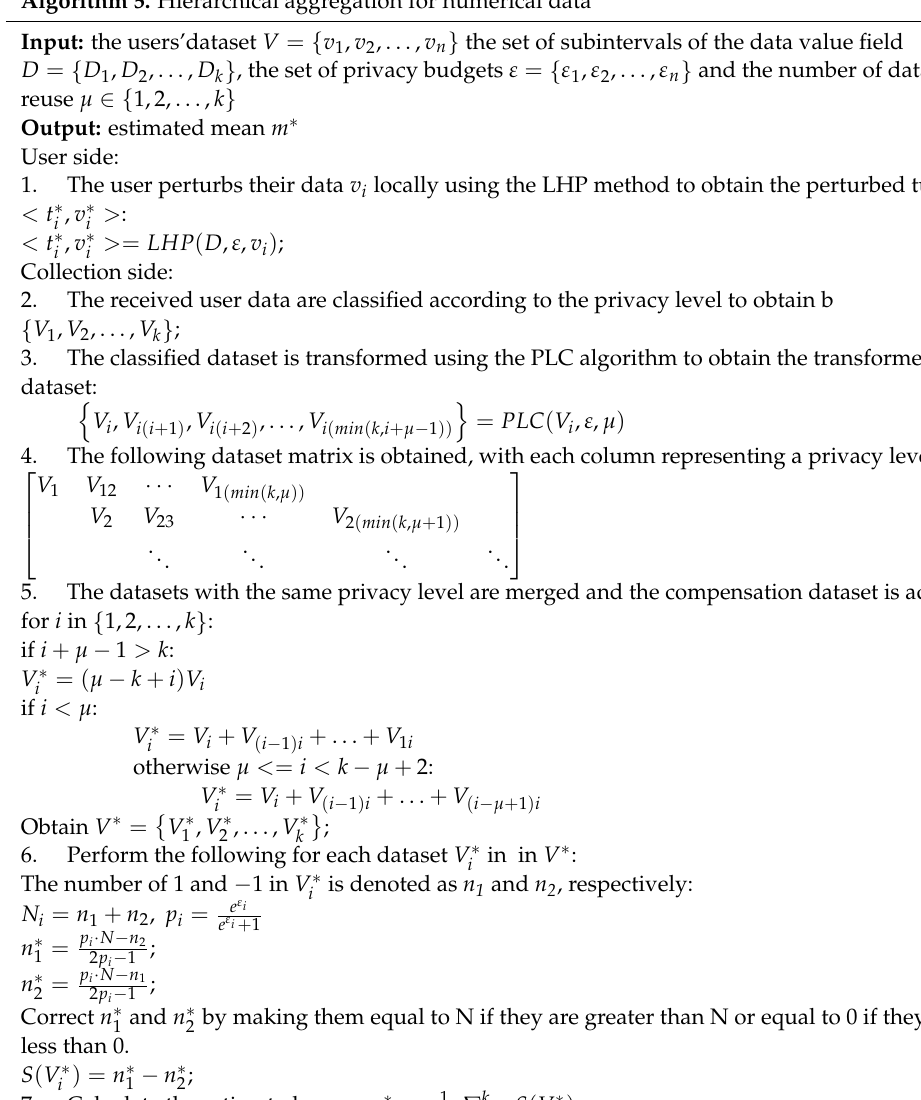
Algorithm 5. Hierarchical aggregation for numerical